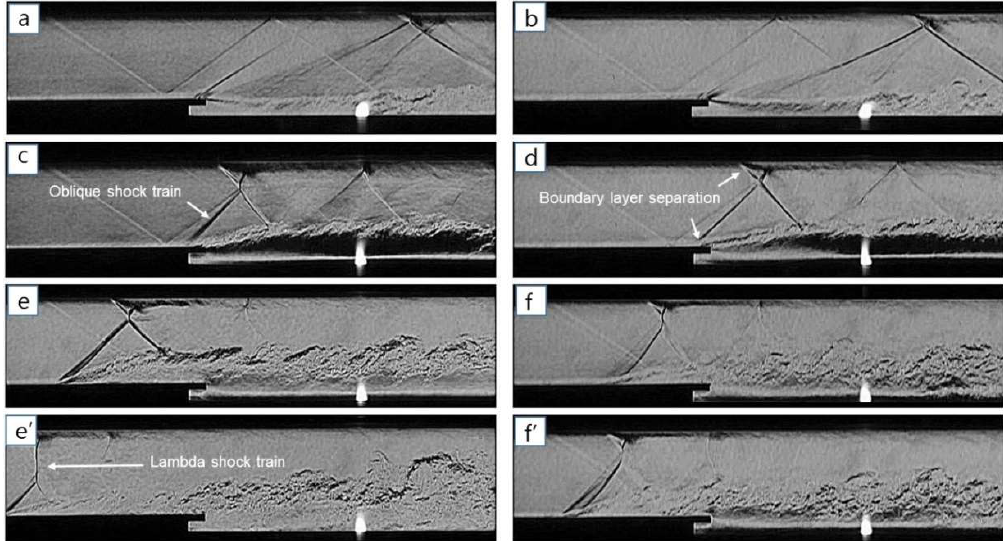
Figure 8. Flow structure transition of the parallel injection for ER rise: vent slot mixer ( a , c , e , e ′ ) and vent circle mixer ( b , d , f , f ′ ).